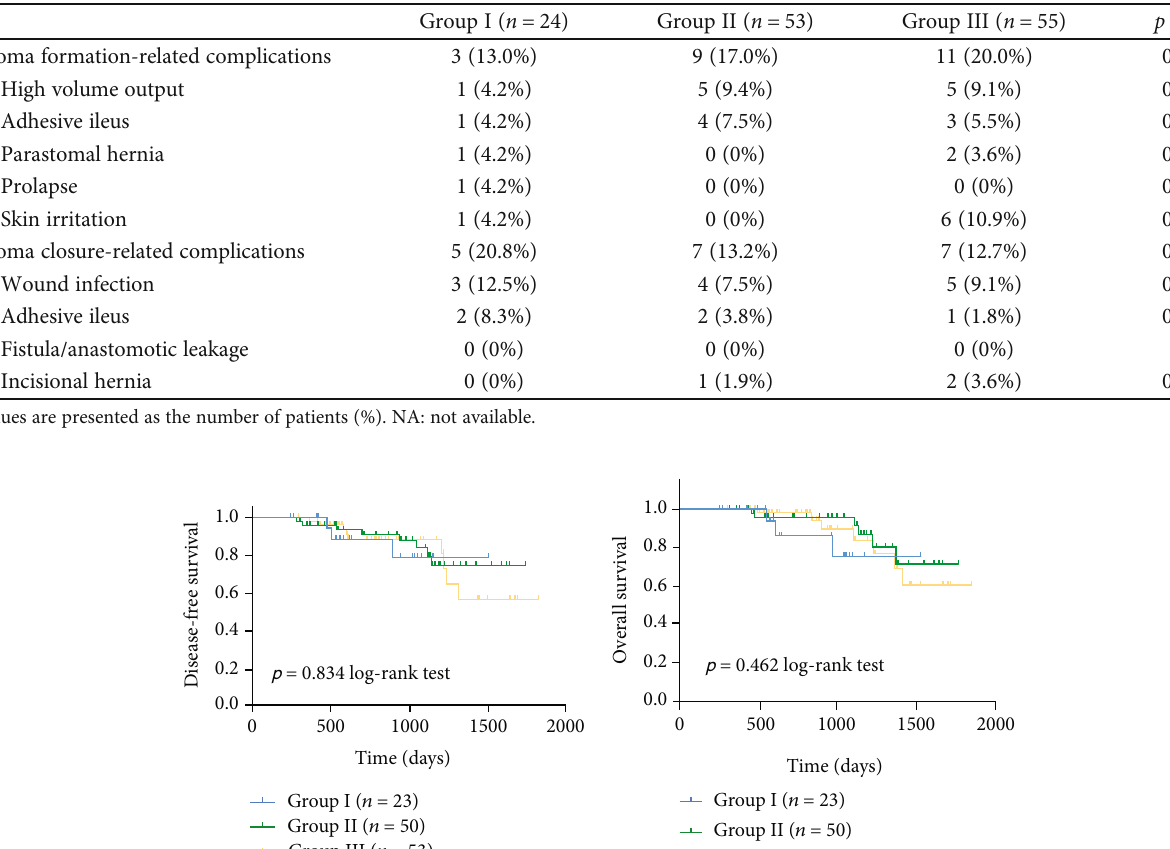
Table 3: Stoma-related complications.